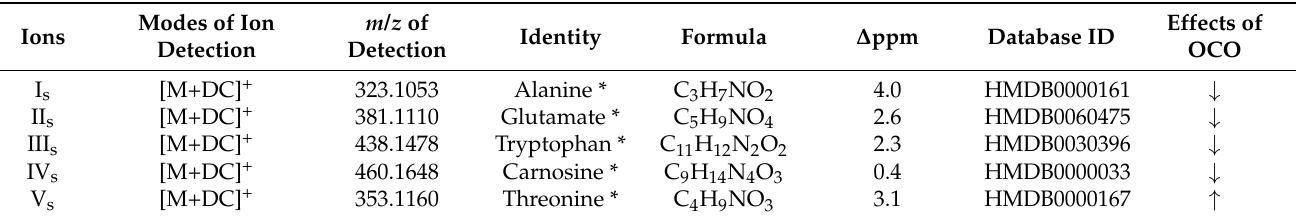
Table 2. Confirmed oxidized corn oil (OCO)-responsive amino-containing metabolites in serum. The metabolites were detected in positive mode after the DC derivatization ([M+DC] + ) and identified as the markers from multivariate modeling.